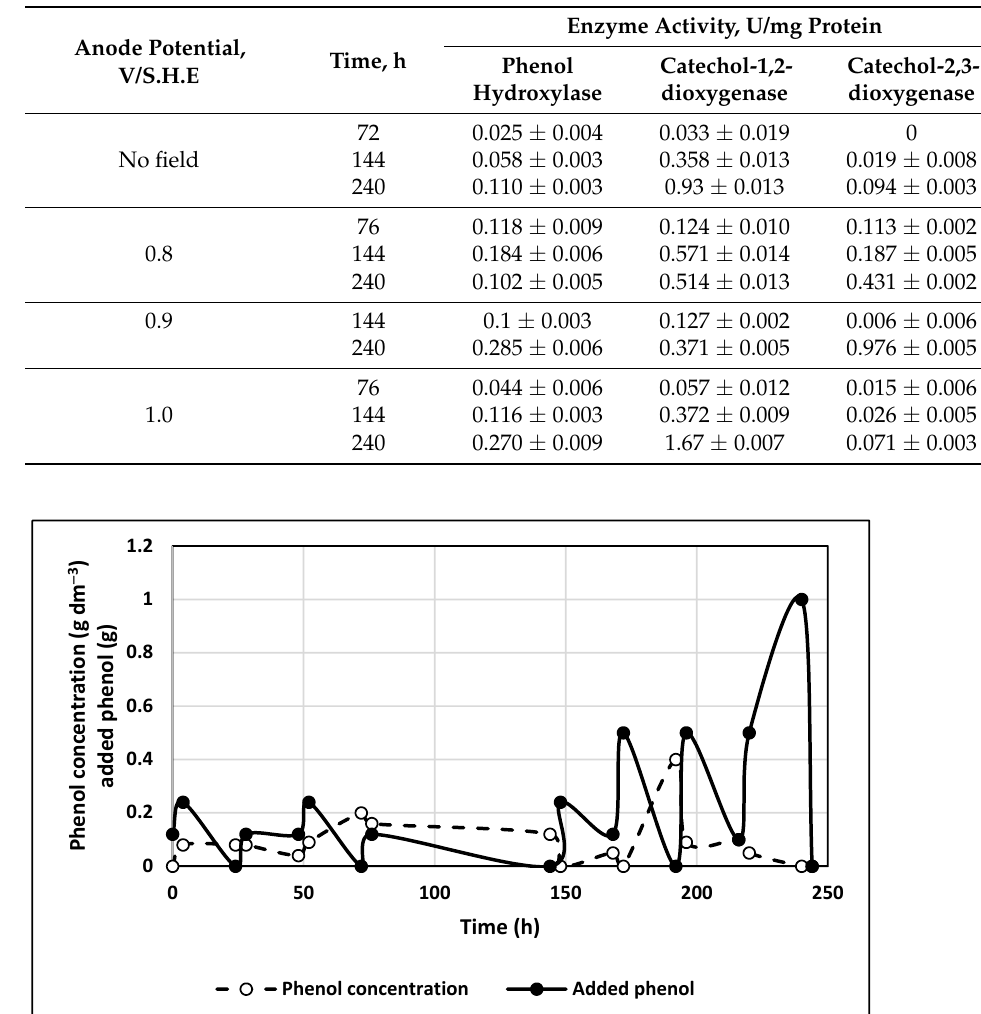
Figure 4. Time profile for experiment with immobilized bacteria without electric field application. Initial phenol concentration, 0.06 g dm −3 .